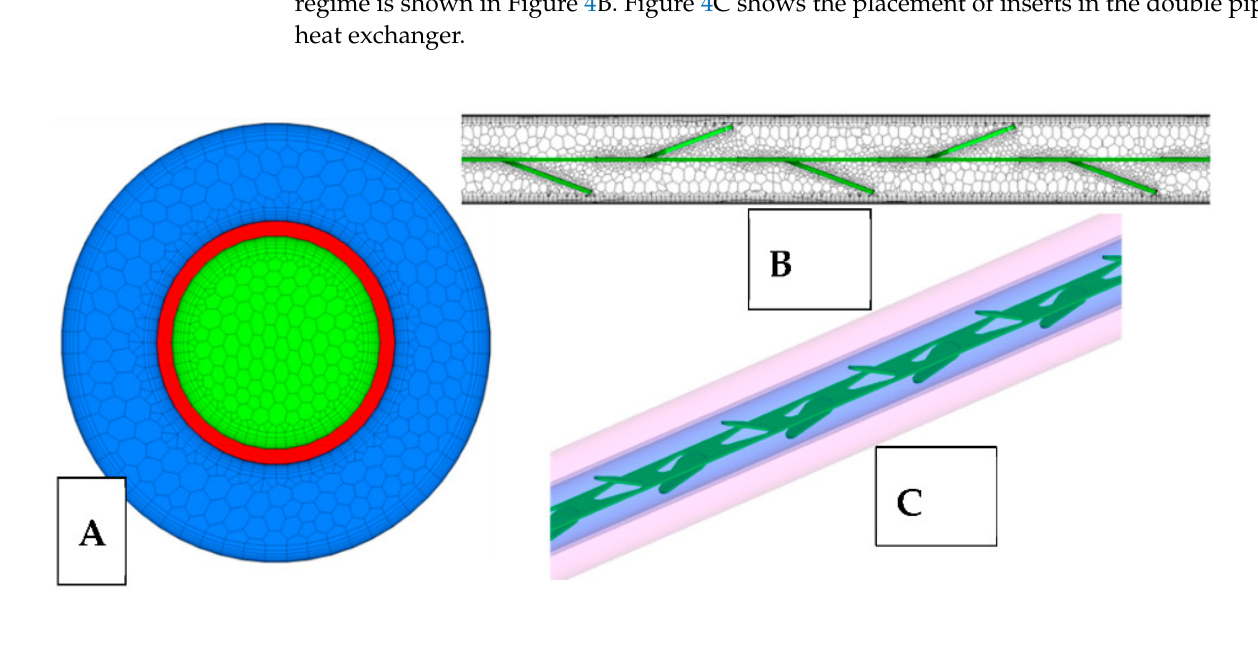
Figure 4. ( A ) Cross-Sectional view of Numerical Model ( B ) Longitudinal view of Numerical Model ( C ) 3D-View of placement of PWT in heat exchanger tube.